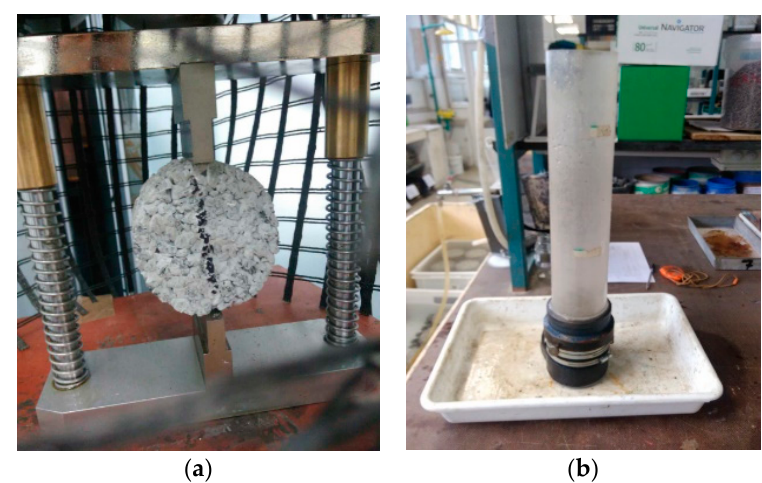
Figure 1. Scheme of PC mixtures comparison.